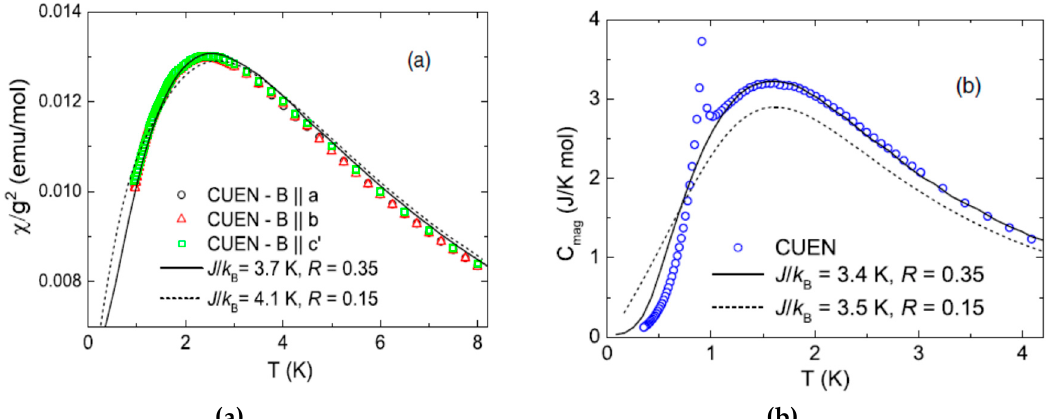
Figure 8. ( a ) Temperature dependence of normalized single-crystal Cu(en)(H 2 O) 2 SO 4 (CUEN) susceptibility in the field 10 mT. Solid and dashed lines represent corresponding QMC calculations ( L = 128) for the S = 1/2 HAF SAZZSL model with R = 0.35 and 0.15, respectively; ( b ) Temperature dependence of magnetic specific heat of CUEN single crystal in zero magnetic field. Solid and dashed lines have the same meaning as in ( a ). (Reproduced with permission from reference [82]).